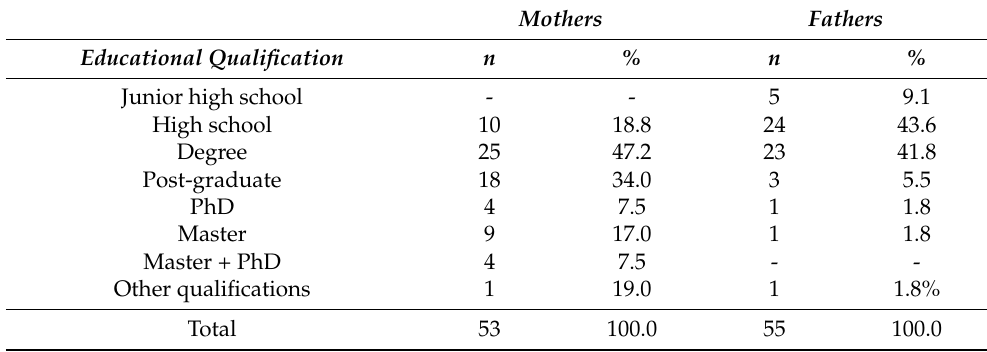
Table 1. Frequency distribution of Educational qualification in mothers’ and fathers’